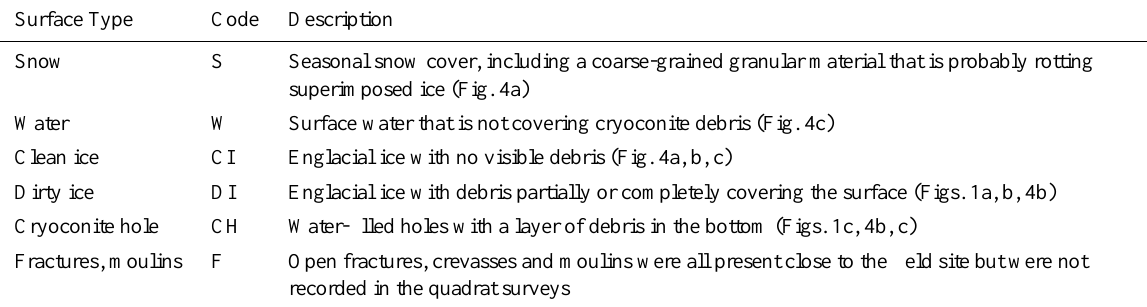
Table 2. List of surface types identified at the field site. All except Type F were present in the quadrat surveys. Surface Type